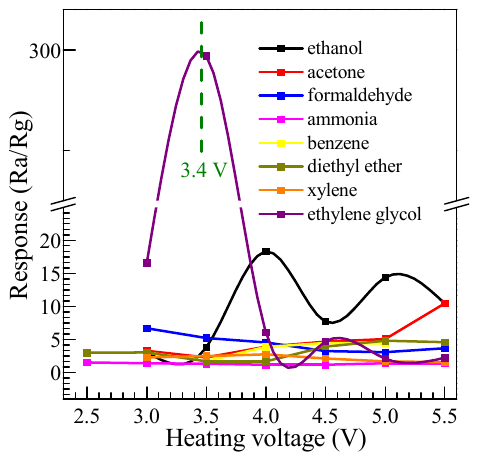
Figure 11. The response of the sensor to different heating voltages at 300 ppm.